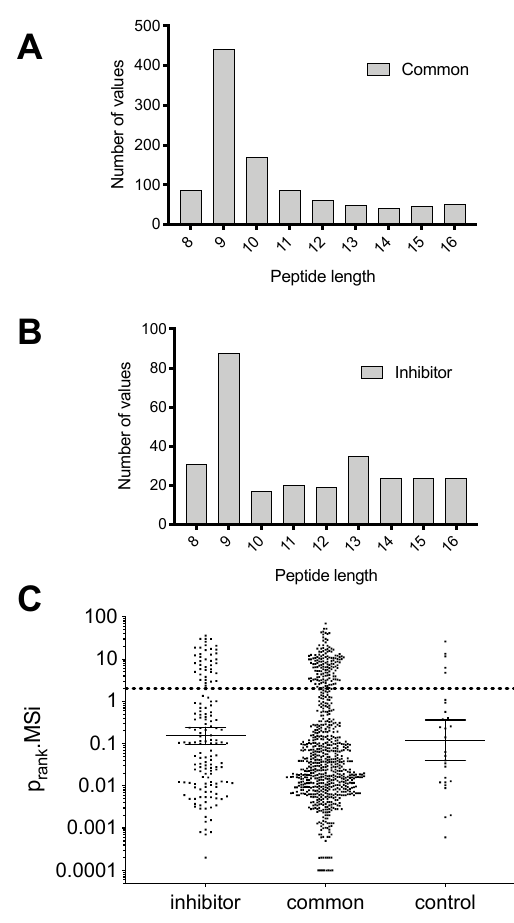
Figure 3. Effects of the inhibitor DG011A on the length and affinity of peptides presented by MOLT-4 cells. Panel ( A ), distribution of lengths of peptide eluted from the MHC class I molecules on the surface of MOLT-4 cells that are unaffected by the presence of the inhibitor. Panel ( B ), same as in panel A but for peptides that were induced by the inhibitor. Panel ( C ), distribution of predicted affinities of each identified peptide for the HLA alleles present in MOLT-4 cells (HLA-A*01:01, HLA-A*25:01, HLA-B*18:01, HLA-B*57:01, HLA-C*06:02, HLA-C*12:03 ) [28]. Each circle denotes a unique peptide sequence. Peptides are grouped as in Panel ( A) .